Question: Identify the chart type used in this figure.
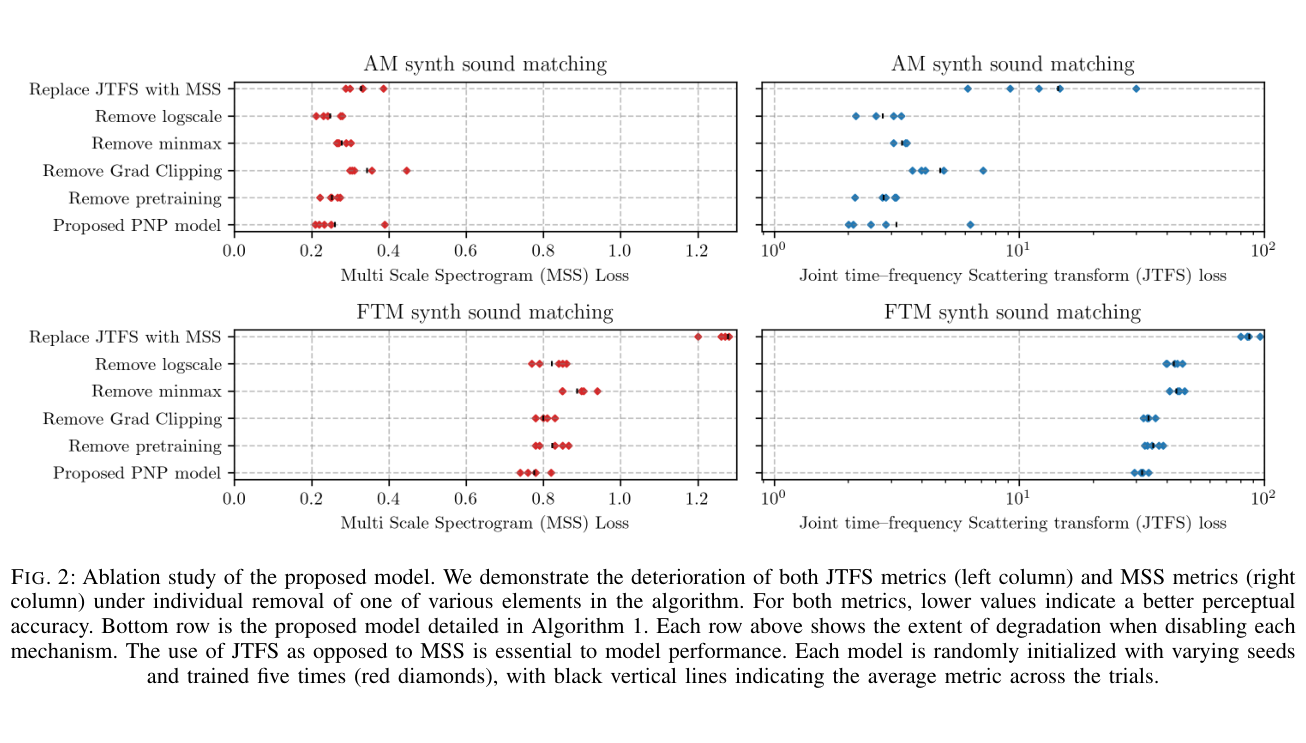
Answer: line